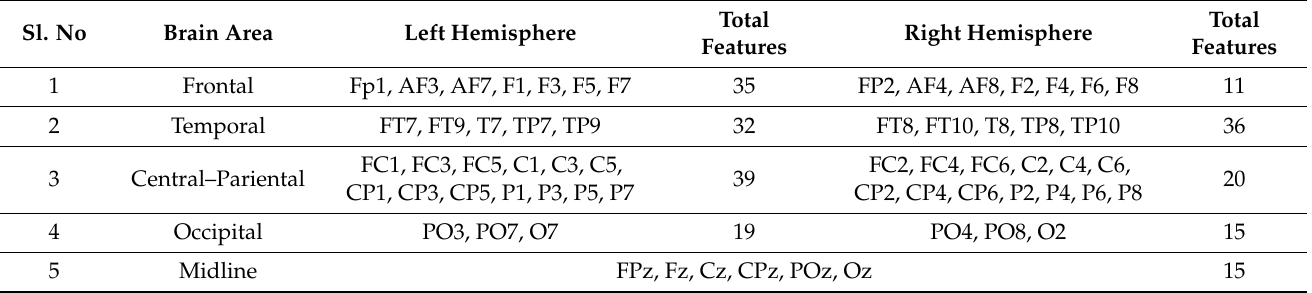
Table 4. EEG channel labeling and channel points in brain